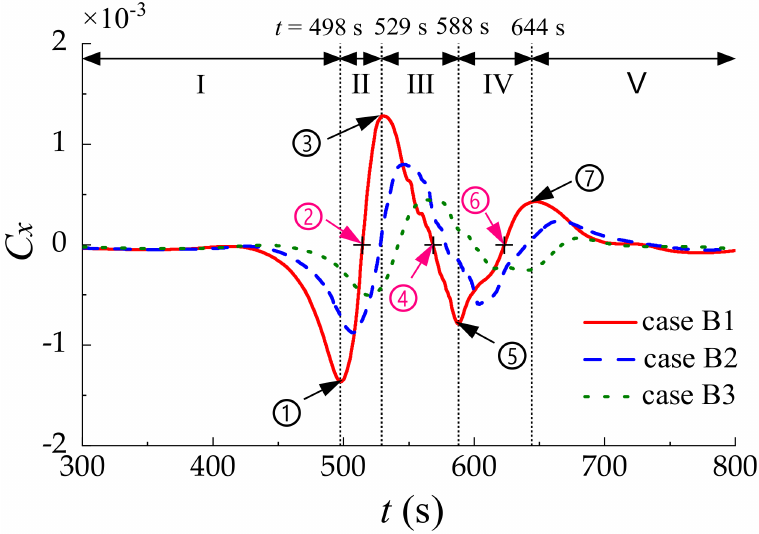
Figure 11. Time series of horizontal force with different thicknesses of the